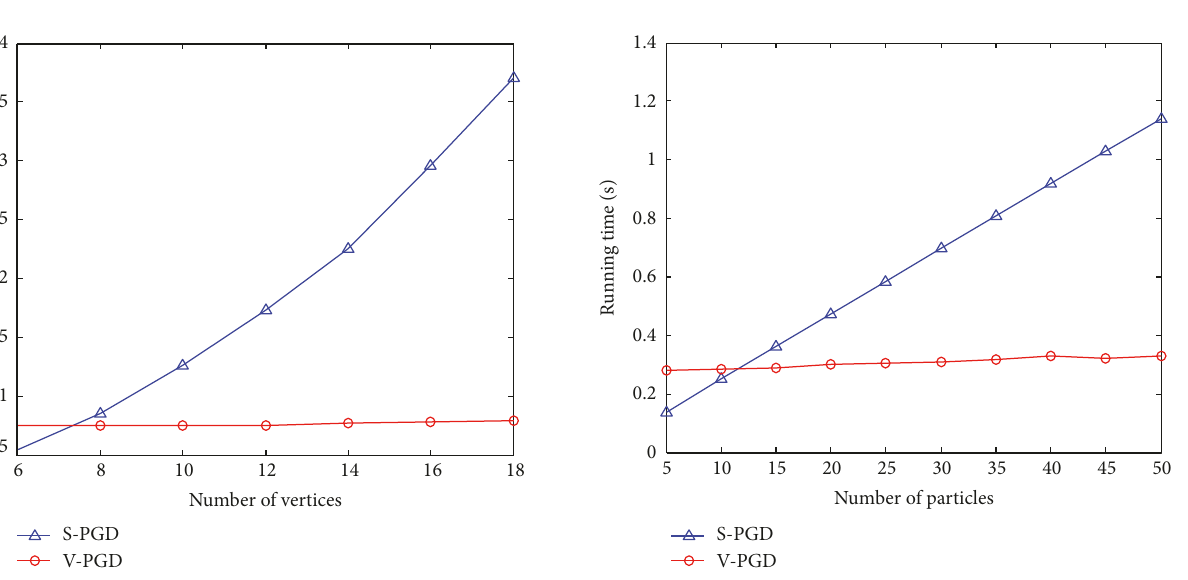
Figure 7: Running times of g11–g17 in Group 1 ( m = 30 and Itr = 1500).